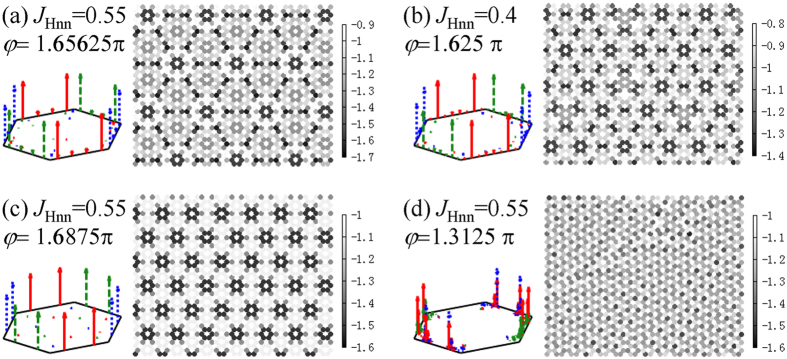
The spin structure factor on the triangular sublattice (Stγ(k)) is shown on the left of each figure for the states (a–c) in P phase and (d) in the region on the left of A phase. The solid (red), dashed (green) and dotted (blue) lines with arrows denote the signals from Sx, Sy and Sz respectively. Correspondingly, the maps of Ei on the honeycomb lattice are given on the right. For visibility, only part of the lattice is shown here, and the shading refers to the value of Ei.